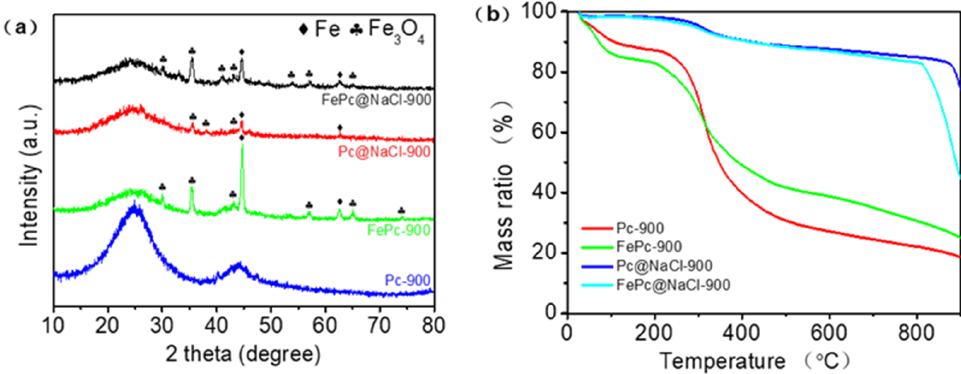
Figure 3. ( a ) XRD patterns of FePC@NaCl-900, PC@NaCl-900, FePC-900 and PC-900, ( b ) TGA curves of FePC@NaCl-900, PC@NaCl-900, FePC-900 and PC-900.